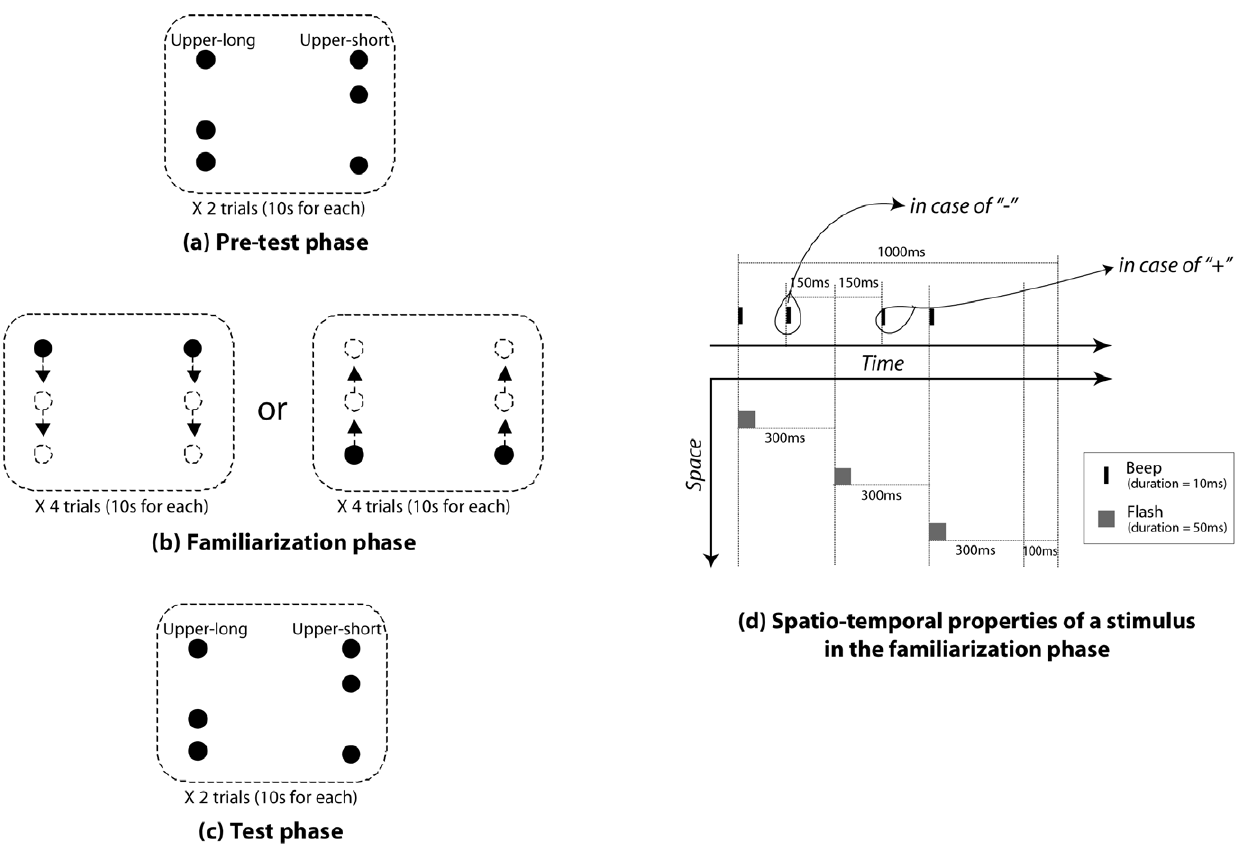
Figure 1. Schematic illustrations of stimuli (a) in the familiarization phase and (b) in the test and (c) pre-test phase. (d) A chart representing spatiotemporal properties of stimuli presented in the familiarization phase.